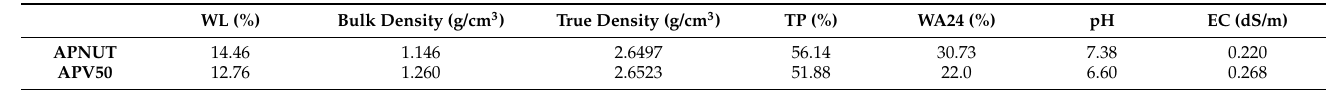
Table 2. Characterization of granules with fertilizer glass (APV50) and with nutrients that were not vitrified (APNUT).